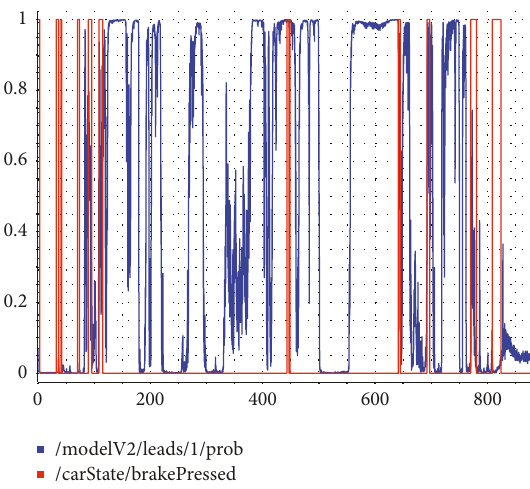
Figure 13: T1D3 lead car detection and